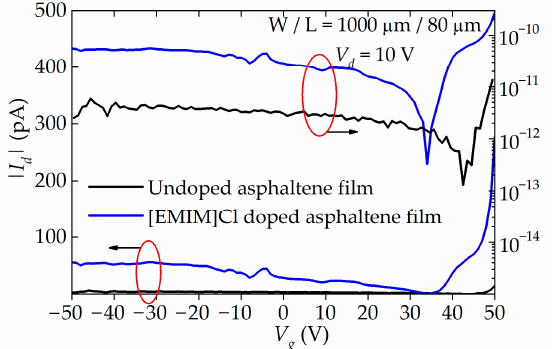
Figure 7. Transfer characteristics, | I d |-V g , of undoped and 90 wt% of [EMIM]Cl-doped OFET plotted in linear and logarithmic scale. Both hole and electron conduction are observed. The transition voltage from hole to electron conduction can be observed at 34.1 V to 42.8 V for doped and undoped OFET. The left-shift of the transition voltage suggests that the asphaltene thin film has been n-doped. The µ h and µ e of the doped and [EMIM]Cl-doped OFETs were extracted from the I d -V g curve. The average value of the µ h and µ e for the undoped OFET are 4.89 × 10 − 8 cm 2 /Vs and 9.73 × 10 − 7 cm 2 /Vs, respectively. On the other hand, the average value of the µ h